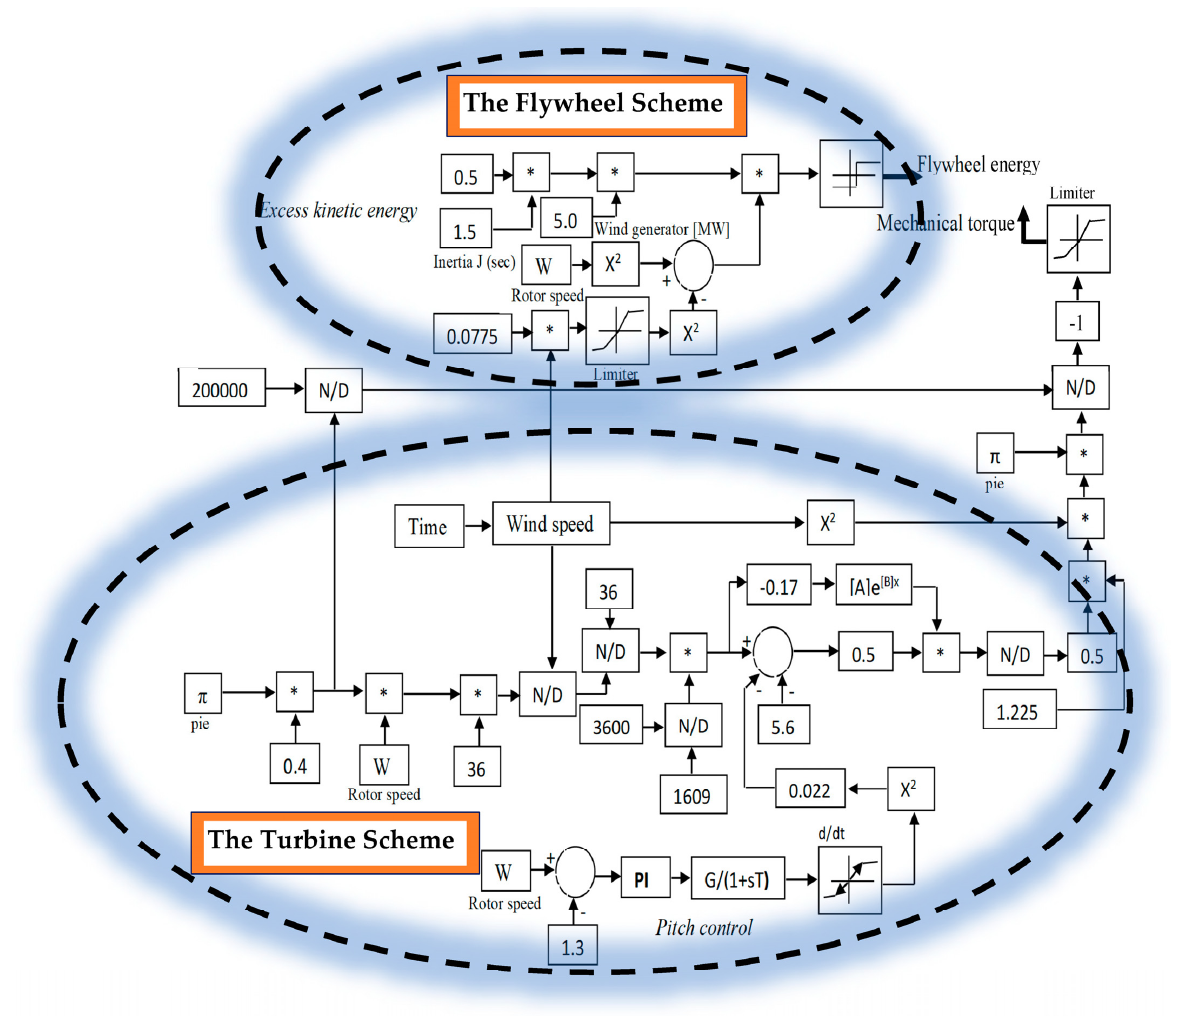
Figure 3. MPPT flywheel control (* means reference